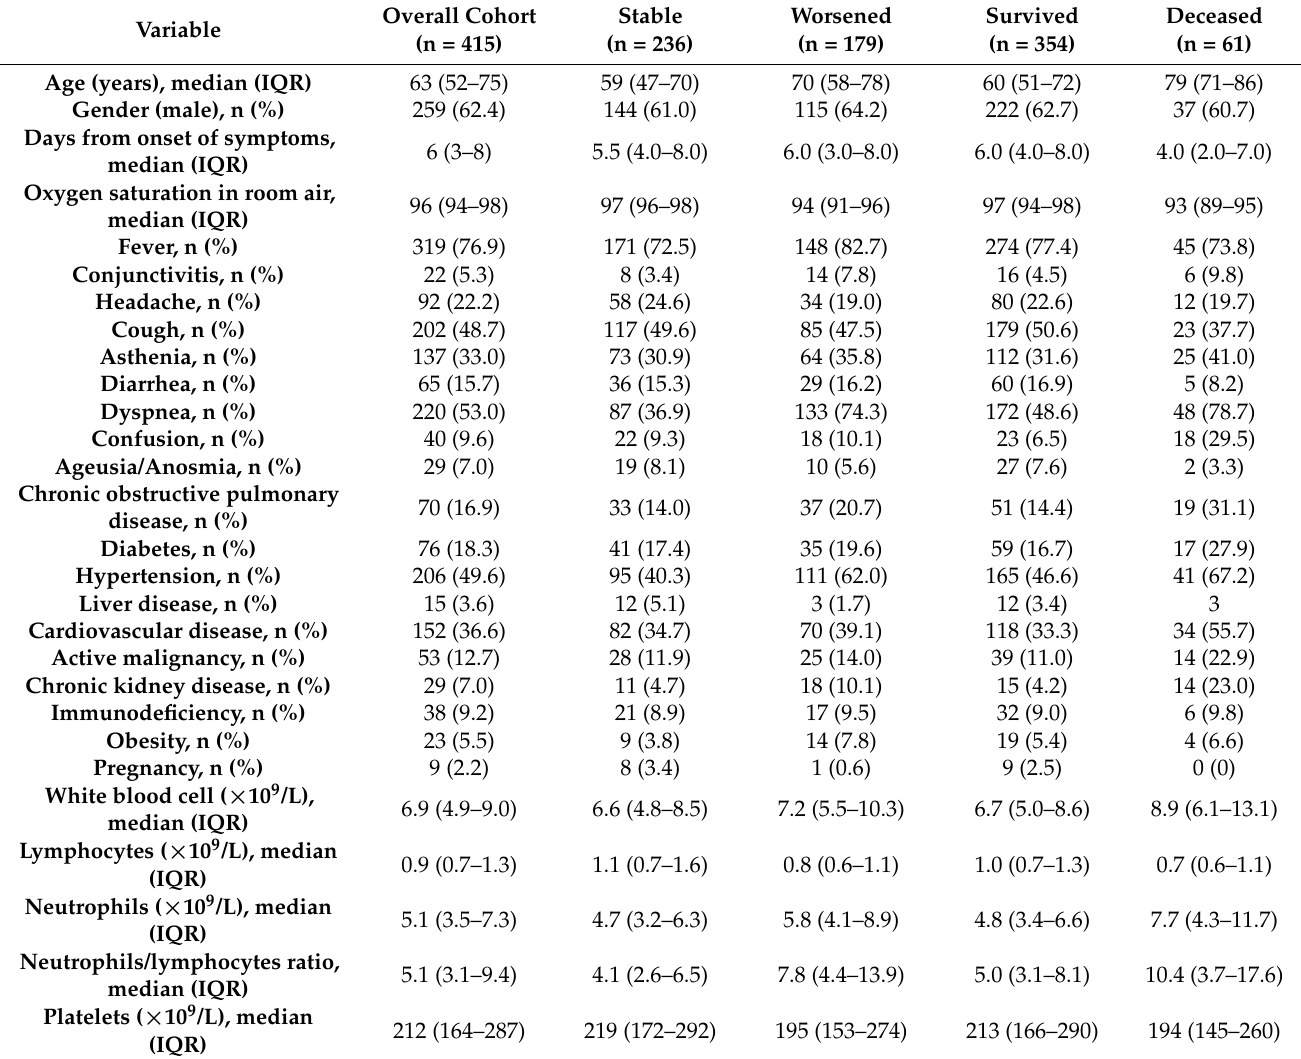
Table 3. Clinical and laboratory characteristics of the validation cohort according to seven-day re-evaluation and